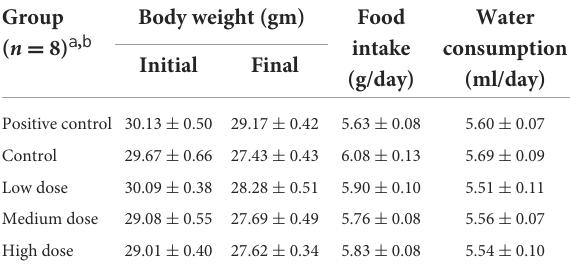
TABLE 1 Changes in body weight and records of food and water intake of SAMP8 mice supplemented with combined extracts. Group